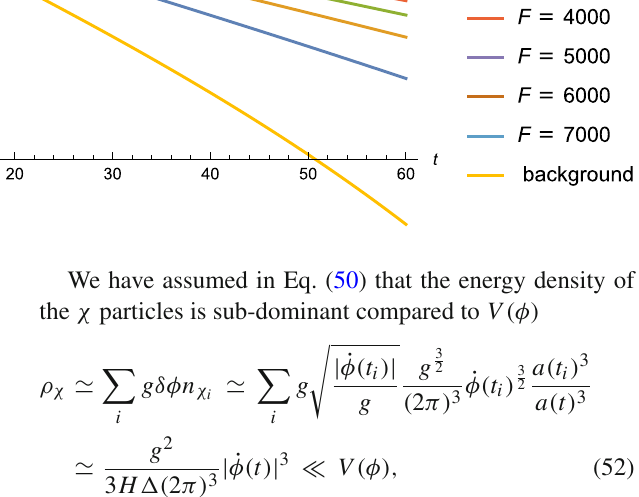
Fig. 4 The evolution of φ starting from φ = 1 m pl for different values of F , with fixed μ = 0 . 1 (in Planck units), and compared with the background